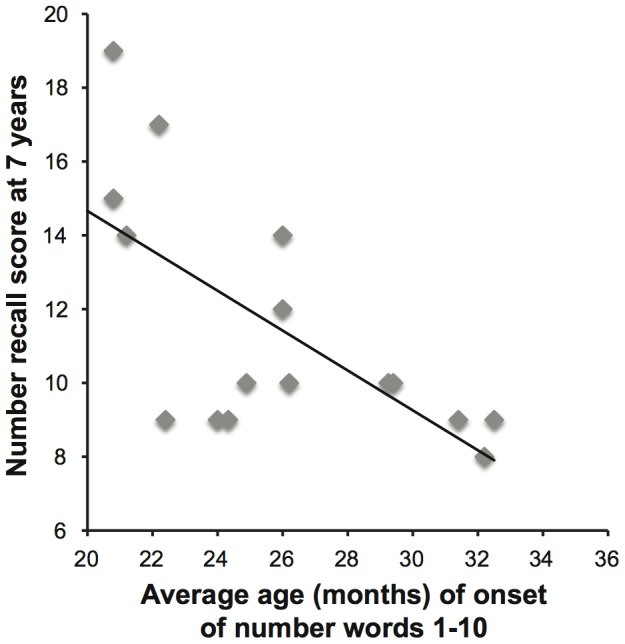
Relation between onset of number word use and later number recall.Scatterplot depicting the average age of onset of the number words 1–10 over the first three years of life and number recall scores at seven years of age.